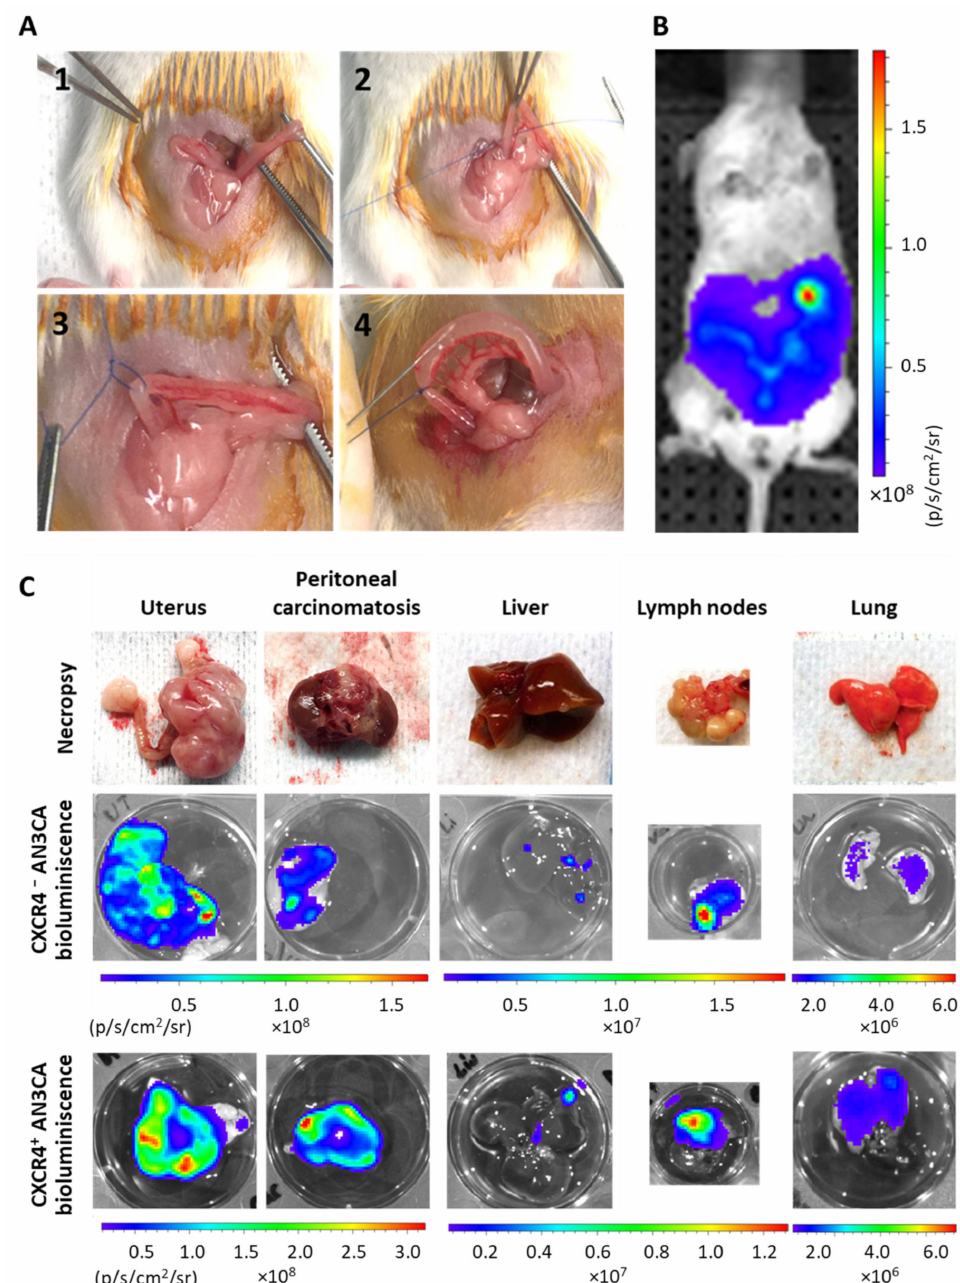
Figure 2. Procedure to orthotopically inoculate human cell lines in NSG mice to obtain an aggressive endometrial cancer model that metastasizes in all clinically relevant organs. ( A ) Representative photographs of the taken procedure, starting by showing uterus exposure (1), followed by right horn ligature without clamping the arterial irrigation system (2 and 3) and intraluminal transmyometrial injection of 10 6 CXCR4 + Luciferase + AN3CA or CXCR4 - Luciferase + AN3CA cells suspended on culture medium using a Hamilton syringe. ( B ) Representative image of Luciferase bioluminiscence emission in a mouse imlpanted with Luciferase + AN3CA cells, indicating the correct engraftment of tumor cells inside the uterus. ( C ) Representative images of relevant organs bearing metastases after necropsy and their ex vivo emission of bioluminiscence, registered by IVIS